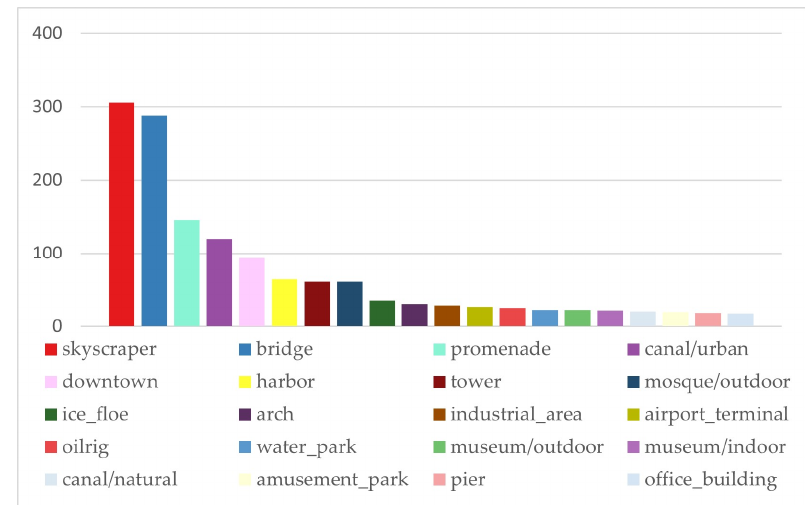
Figure 9. Top 20 top-1 predicted image classification results.